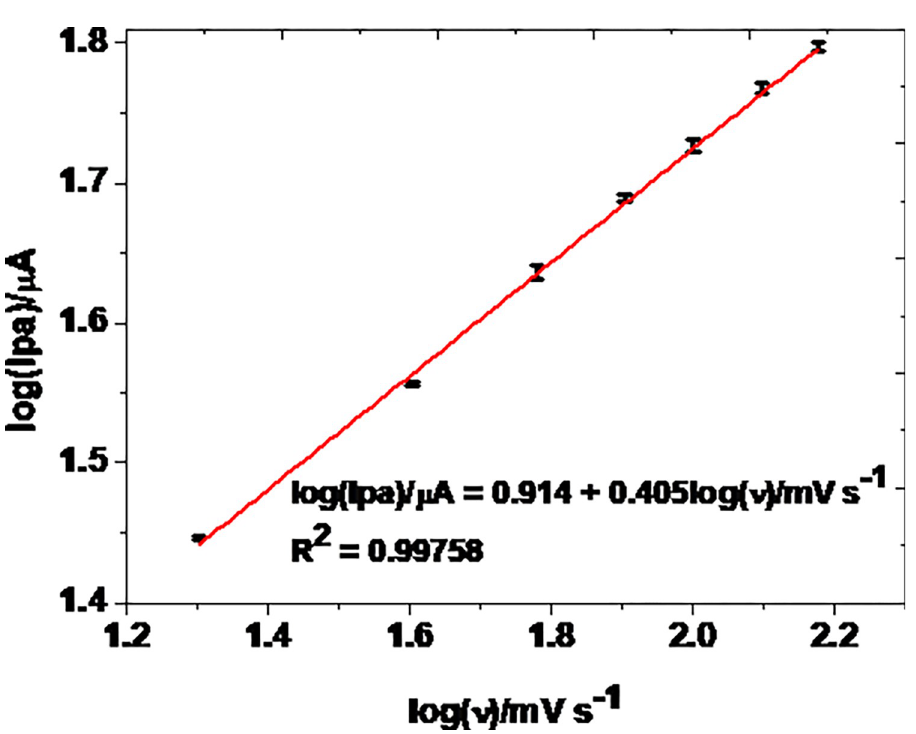
Fig 7. Plot of log of average Ip versus log (v) in the studied range of scan rate (n 3).